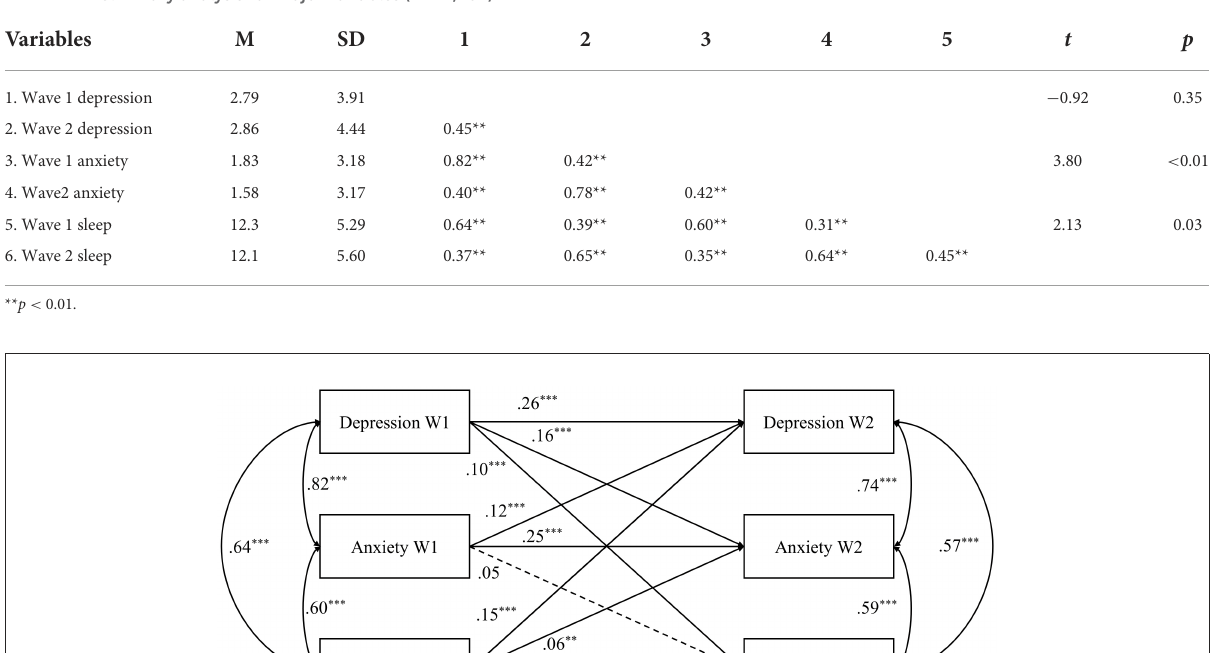
TABLE 1 Preliminary analysis for major variables ( n = 2,787).